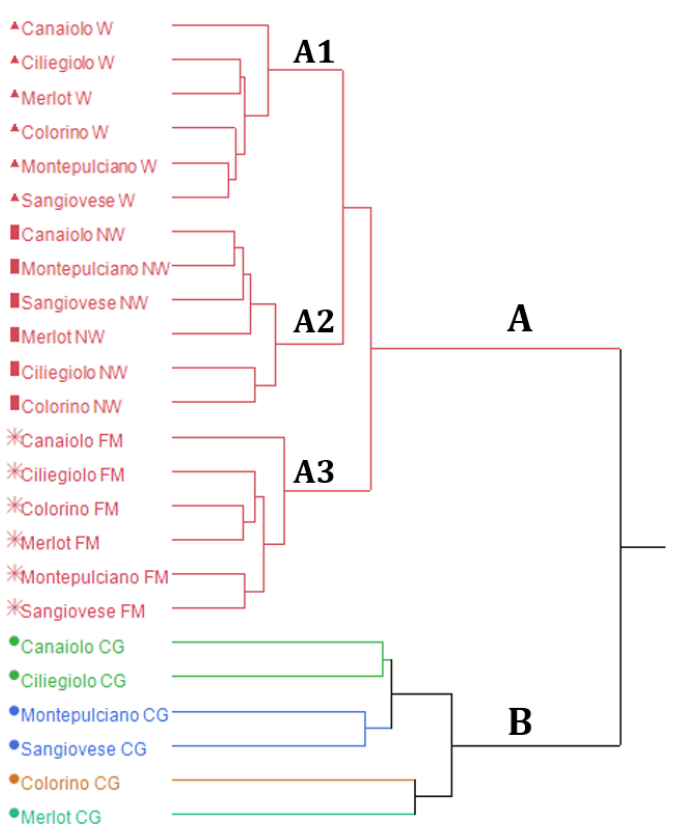
Figure 1. Hierarchical cluster analysis (HCA) dendrogram.